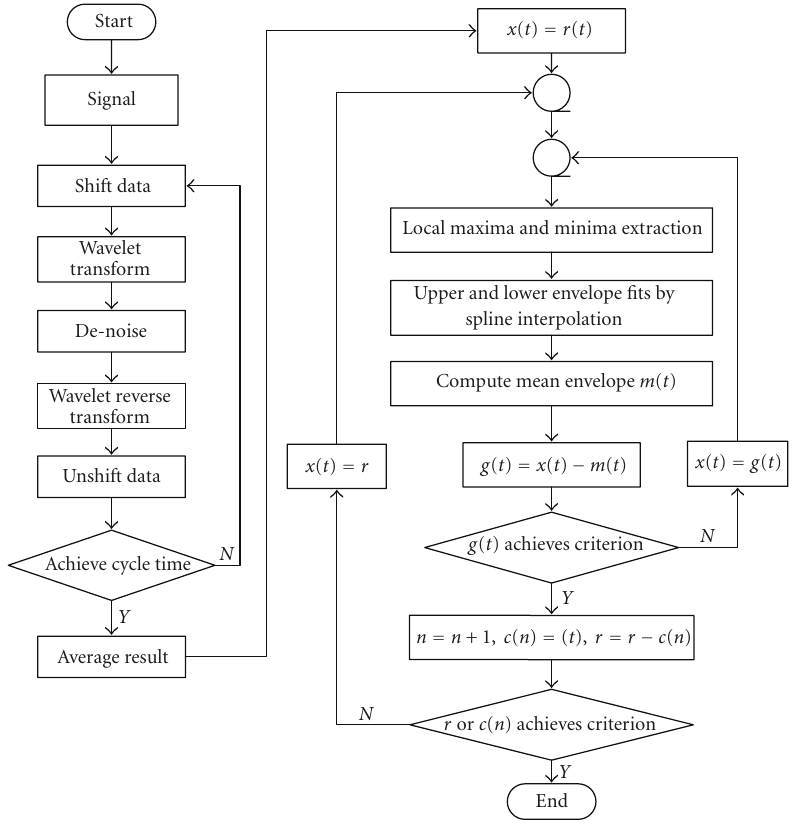
Figure 4: The flowchart of the proposed method.